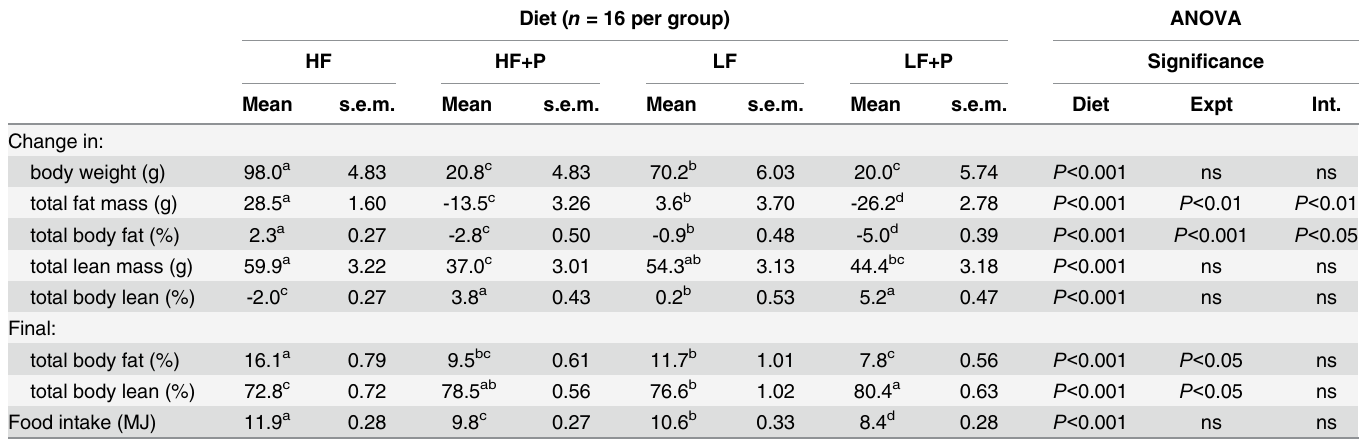
Table 2. Body composition and food intake. Changes in body weight and body composition, final percentage total body fat and lean, and cumulative food energy intake in diet-induced obese rats fed high fat diet (HF), high fat diet with 10% w/w pectin (HF+P), low fat diet (LF) or low fat diet with 10% w/w pectin (LF+P) for 4 weeks in two independently replicated experiments. Within rows, means with different superscript letters are significantly different (ANOVA fol- lowed by Tukey ’ s post hoc